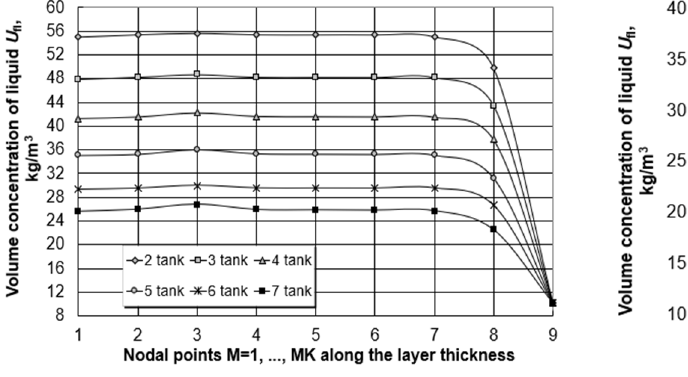
gas environment is equal to its equilibrium value [27].